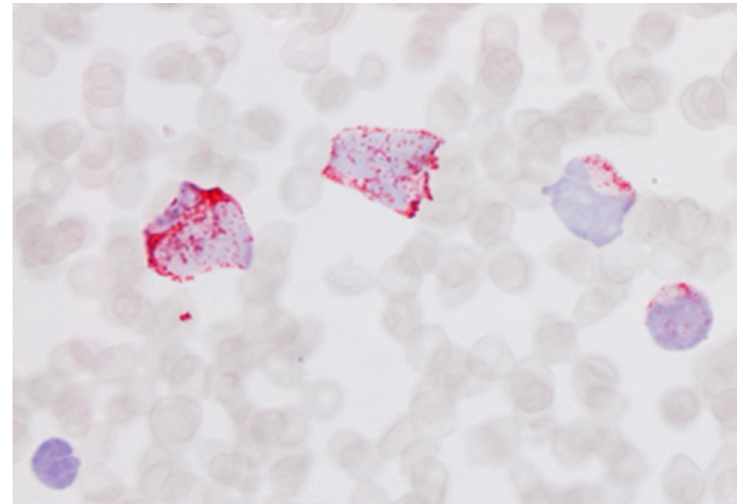
Figure 2. Blood film of acute myeloblastic leukaemia stained with an anti-myeloperoxidase antibody showing cytoplasmic positivity of the blast cells (blood smear; haematoxylin counterstain. ×1000).